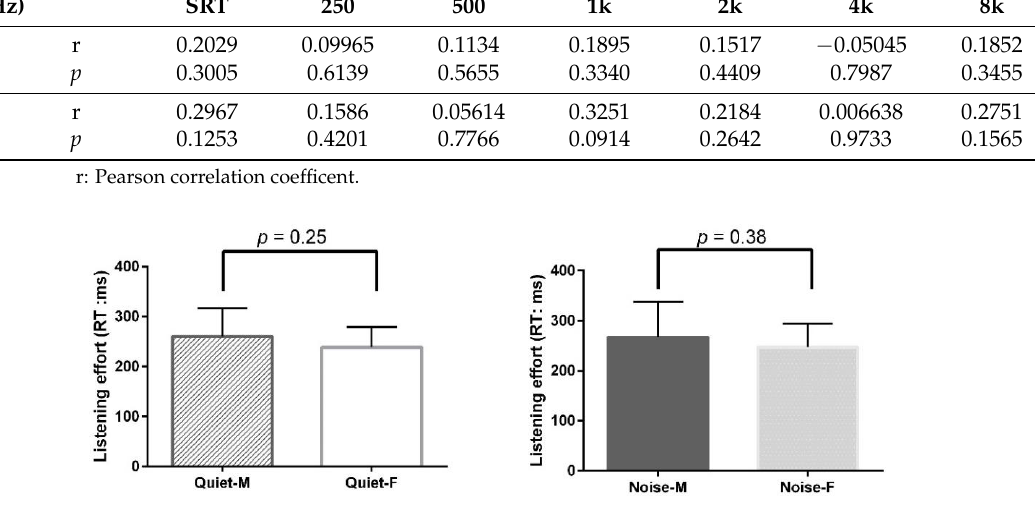
Table A3. Correlation analysis of Listening effort and SRT/PTA frequencies in right side. Right Side (Hz)